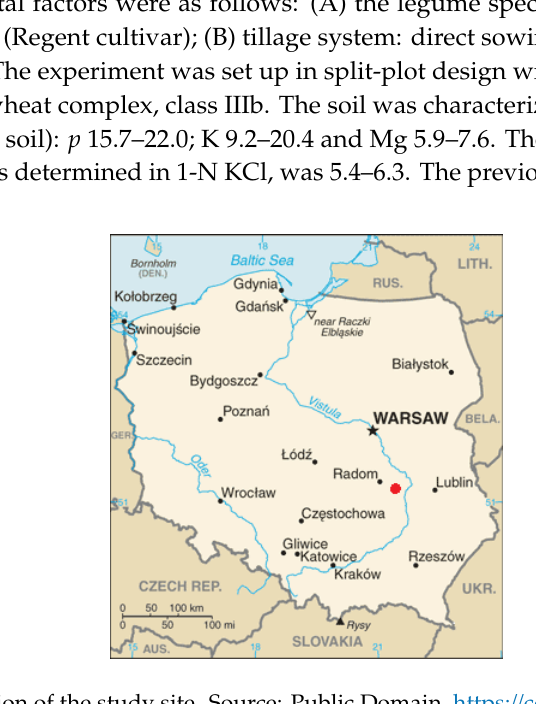
Figure 1. Localization of the study site. Source: Public